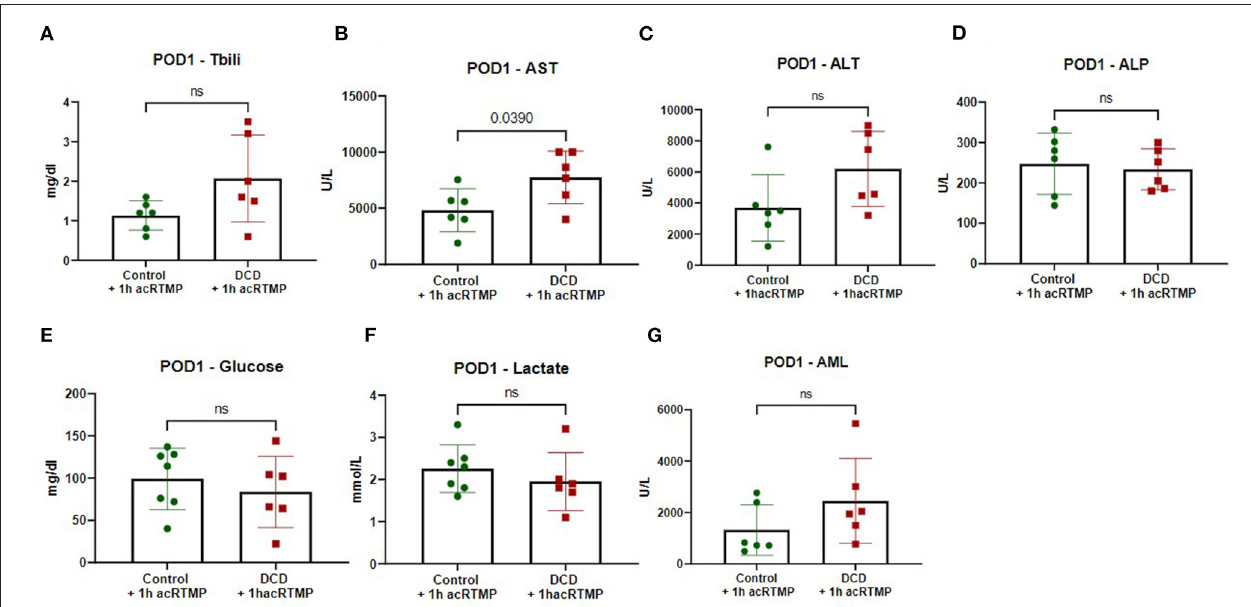
FIGURE 8 | (A-G) Biochemical parameters in recipients on post-operative day 1 following liver